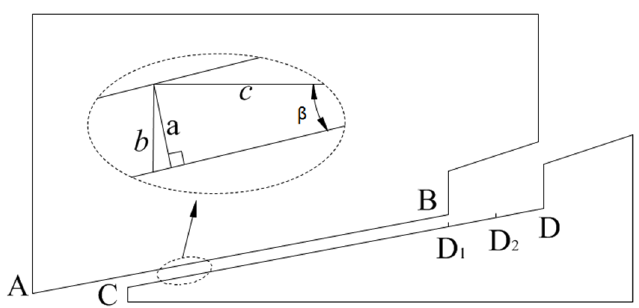
Figure 2. Schematic diagram of the mating surfaces between the inner ring and the outer ring.